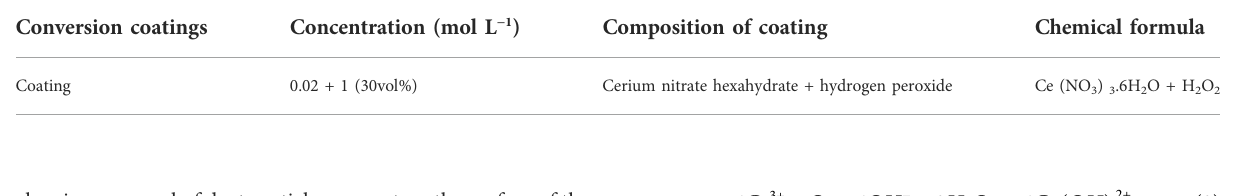
TABLE 1 Chemical compositions of Ce-based conversion